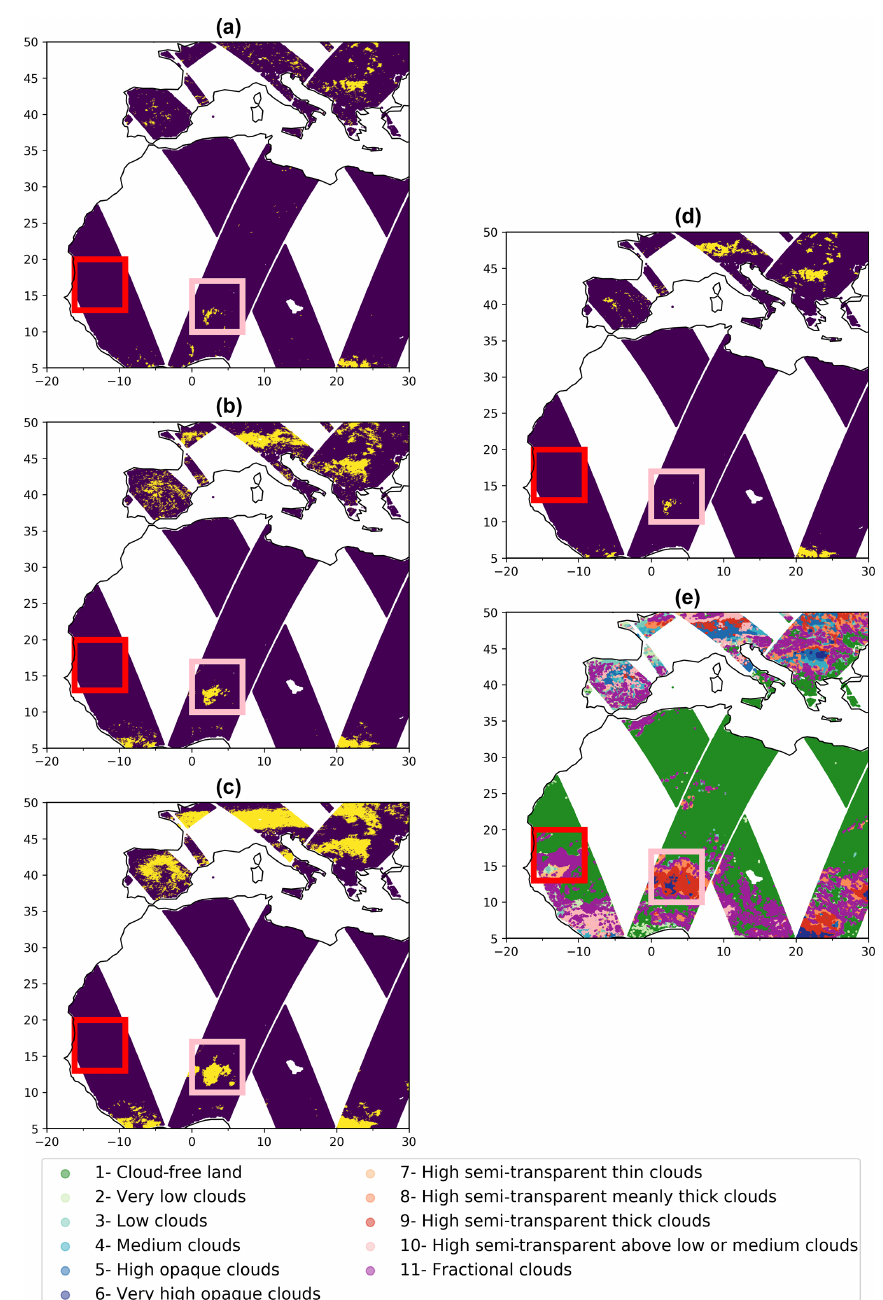
Figure 6. Maps showing for the 15 June 2015: (a) the predicted grid cells flagged by the model using channels below 40GHz with a 0.1 threshold; (b) by the model using channels below 100GHz with a 0.05 threshold; (c) by the model using channels below 190GHz with a 0.01 threshold; (d) the detected precipitating cells according to Ferraro (1997); and (e) the cloudy classes from SEVIRI. The red and the pink square boxes highlight two smaller regions further discussed in Sect.